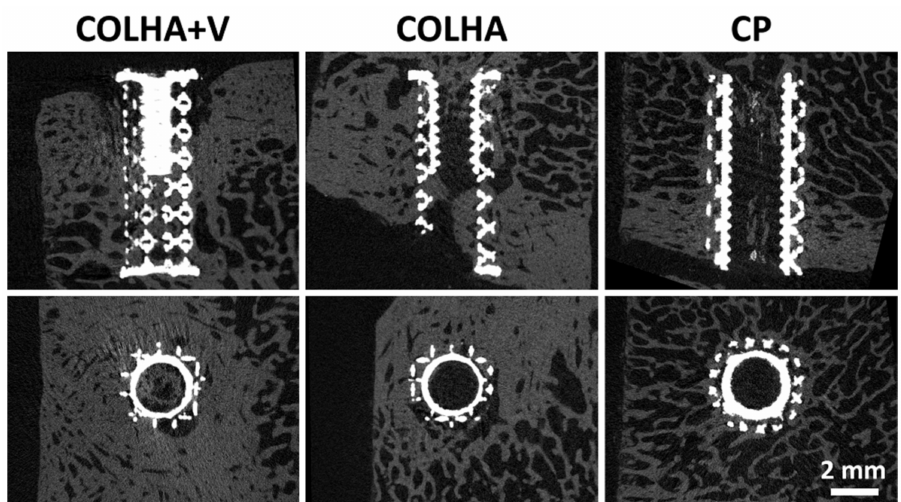
Figure 9. Representative micro-CT images of the implanted titanium samples with collagen/ hydroxyapatite electrospun layers with (COLHA+V) and without (COLHA) vancomycin and the control samples without an electrospun layer (CP).